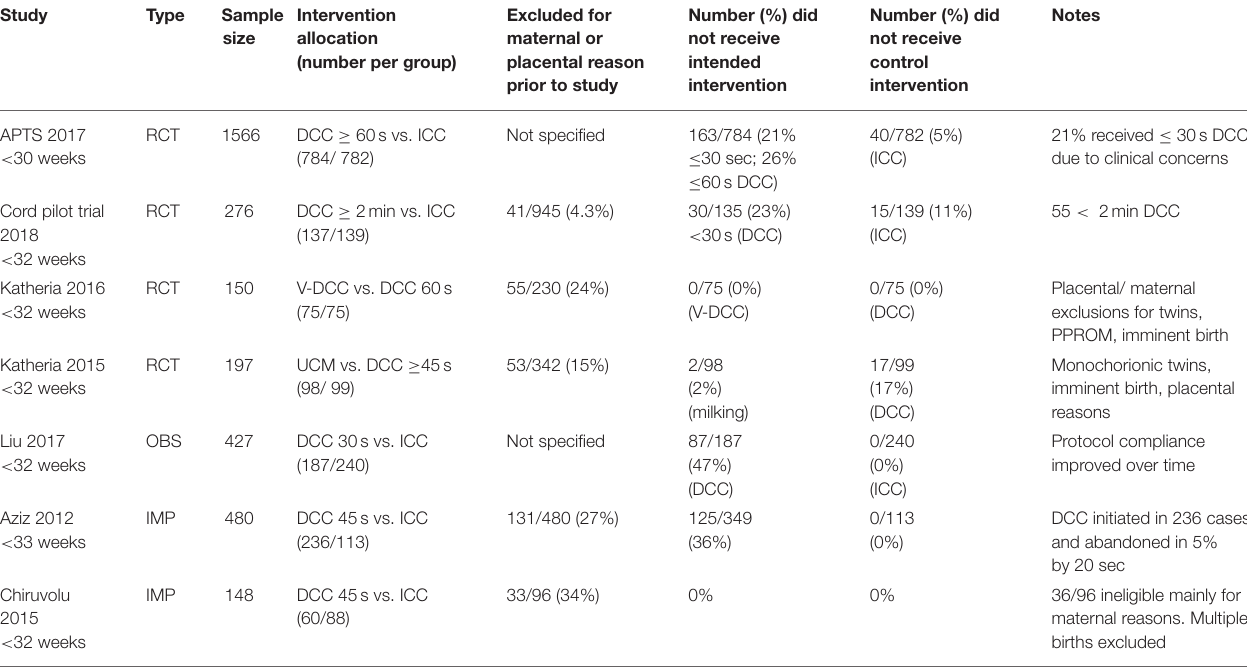
TABLE 1 | Summary data from large studies detailing implementation of delayed cord